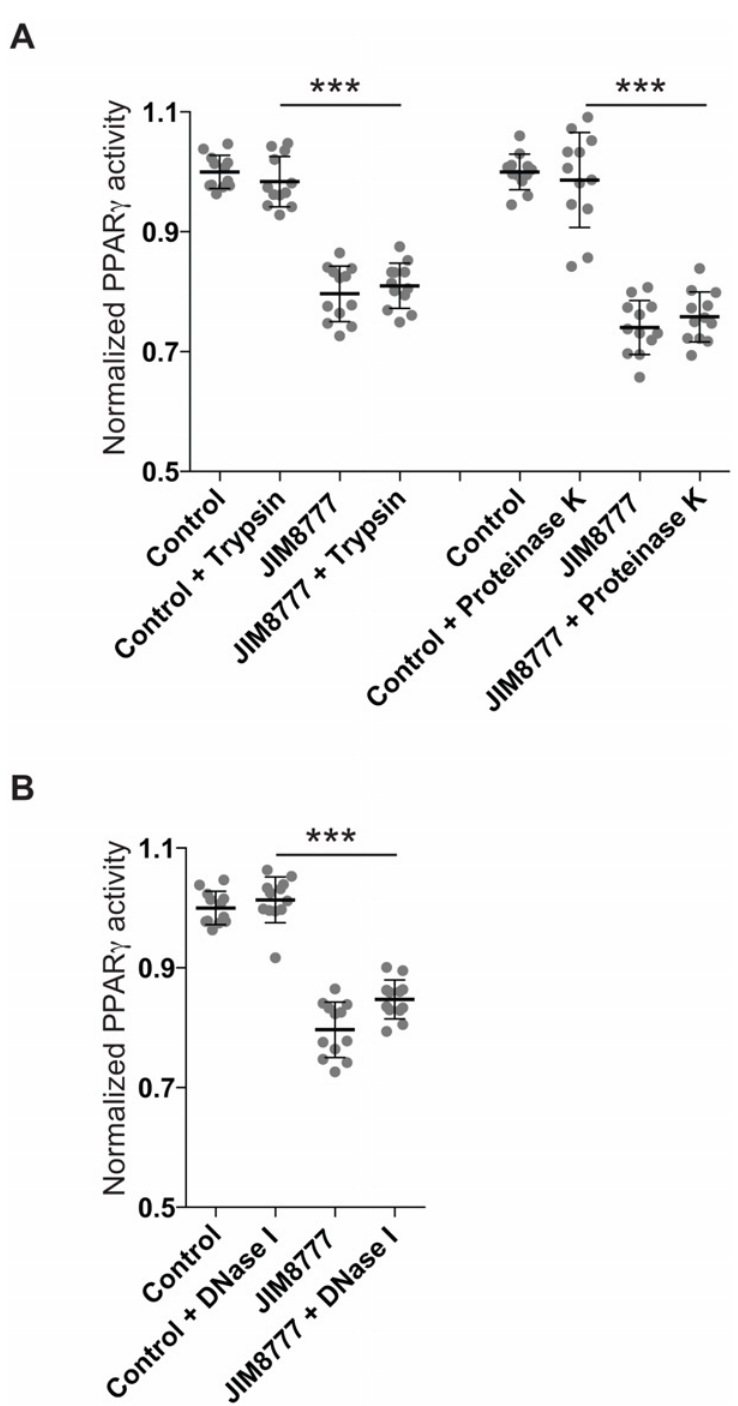
Fig 5. The S . salivarius bioactive compounds are not from peptidic or nucleotidic origin. A- 3kDa- filtered S . salivarius JIM8777 supernatants were exposed to proteases (trypsin, left panel; proteinase K, right panel) prior to addition to butyrate-activated HT-29-PPAR γ cells. B- 3kDa-filtered S . salivarius JIM8777 supernatants were exposed to DNase I prior to addition to butyrate-activated HT-29-PPAR γ cells.